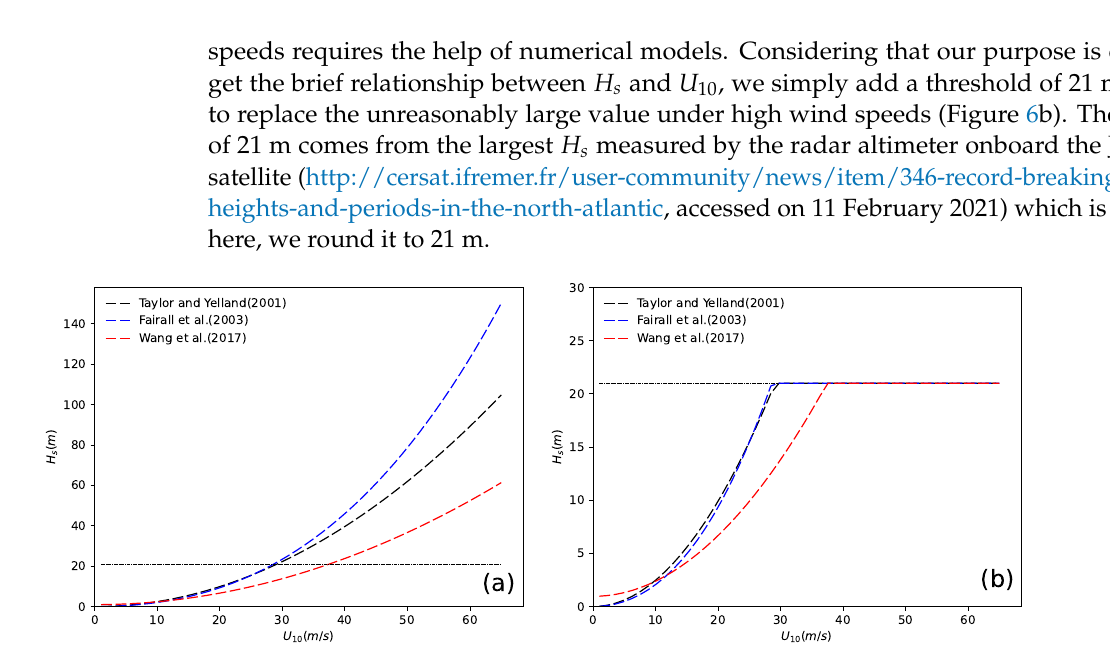
Figure 6. H s versus U 10 ( a ) without threshold and ( b ) with threshold from Taylor and Yelland [51], Fairall et al. [81], and Wang et al. [82]. The threshold of H s = 21 m is shown as the thin dashed